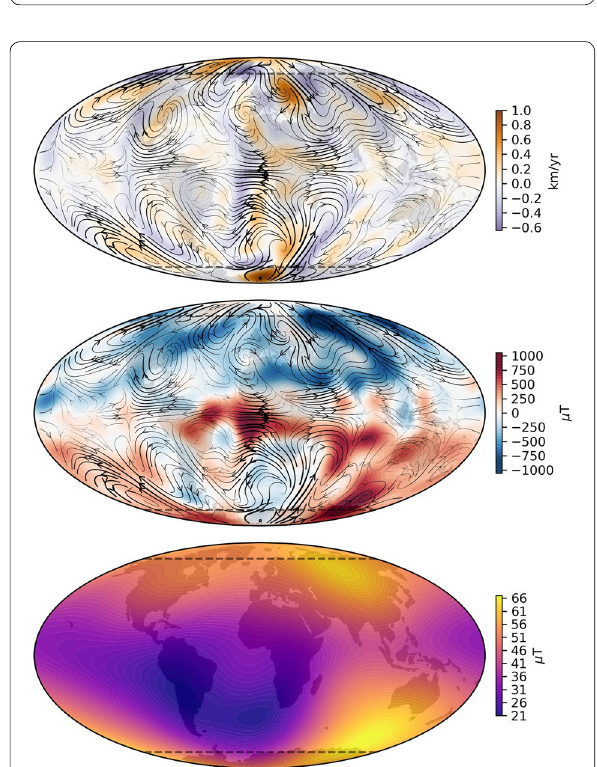
Fig. 15 Same as Fig. 13, but for the forecast in